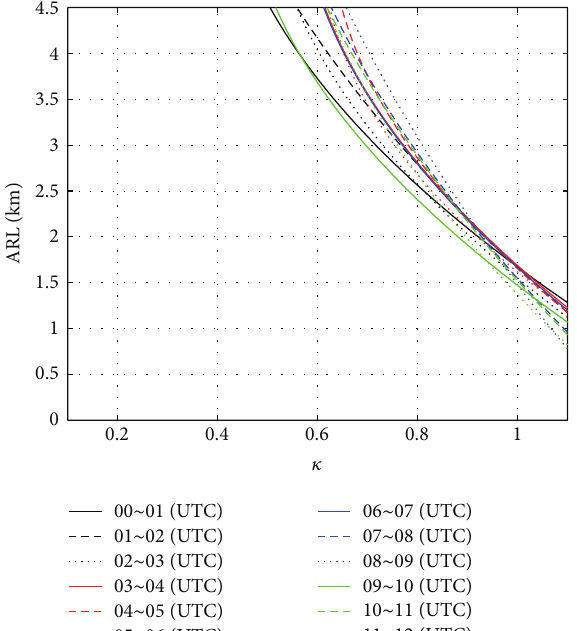
Figure 3: The hourly fitted vertical profiles of specific differential phase (VPSDP) results using data of 12 hours (0000 to 1200 UTC on 9 August 2009). The 𝑥 -axis is the normalized VPSDPs, and 𝑦 -axis is the height above radar level.